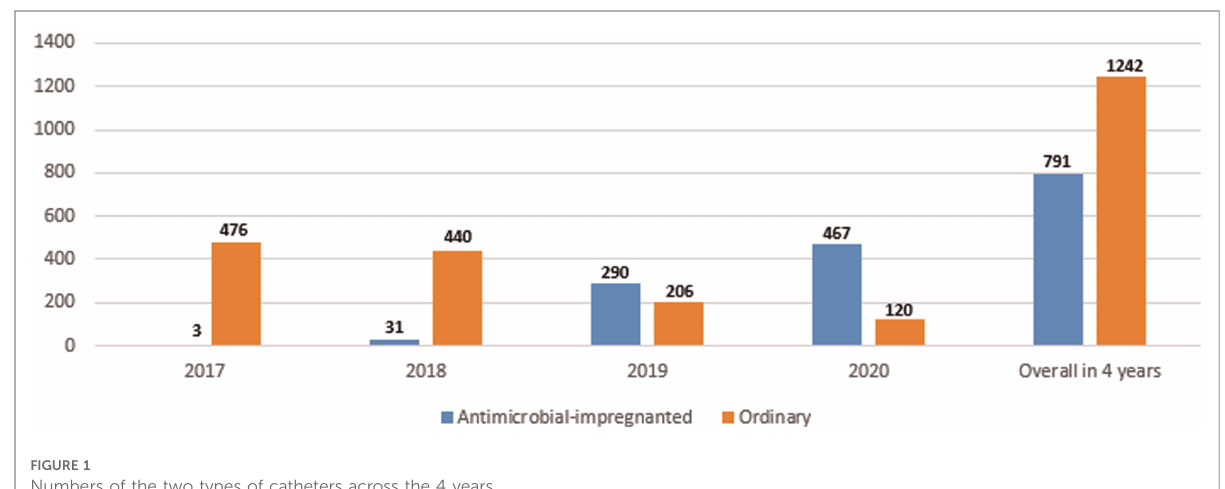
FIGURE 1 Numbers of the two types of catheters across the 4